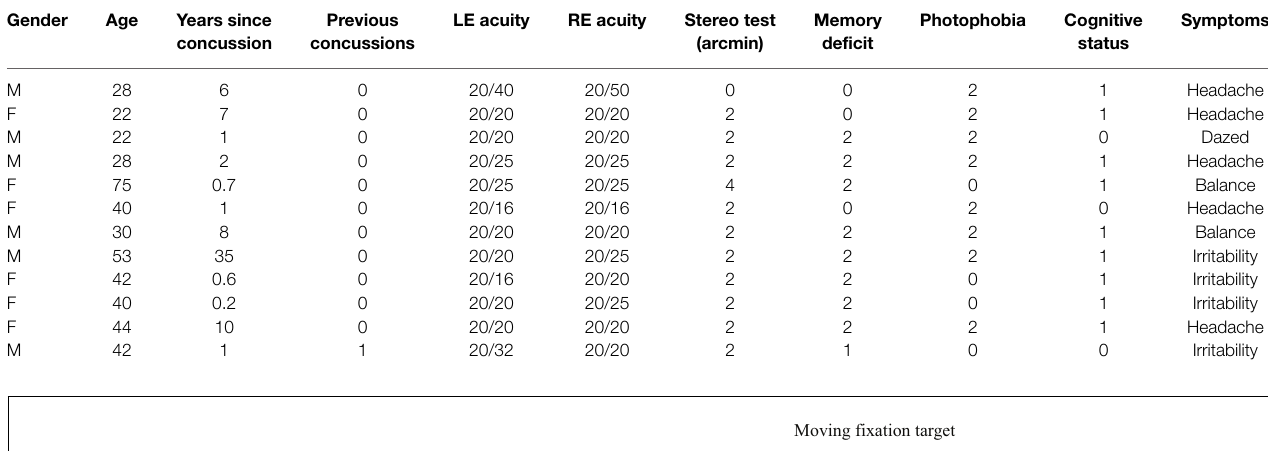
TABLE 1 | dTBI participant characteristics .